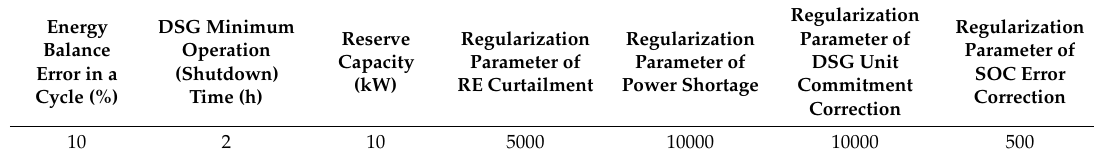
Table 5. Parameters of multi-timescale coordinated control (day-ahead and intraday model).